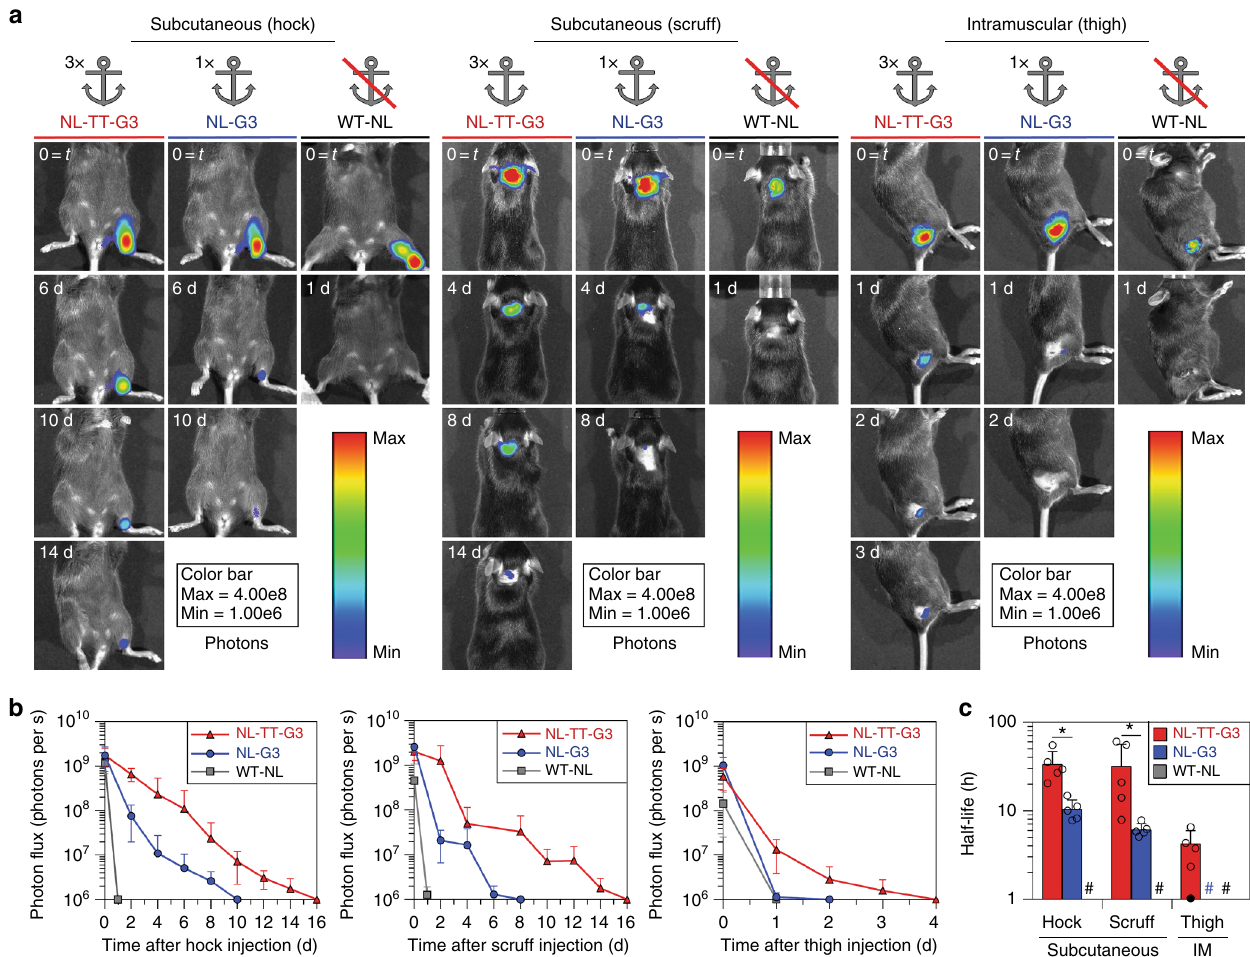
Fig. 5 Injection site half-life of monomeric G3 fusion proteins and trimeric nanoassemblies. a Bioluminescence images and b photon fl ux at various time points for mice that received NL-TT-G3, NL-G3, or WT-NL (equivalent moles of NL) in the hock, scruff, or thigh. c Biocatalytic activity half-life of NL-TT-G3, NL-G3, or WT-NL in different tissues. N = 5, mean ± s.d., * p < 0.05, ANOVA with Tukey ’ s post hoc. In c , open circles represent each half-life calculation, closed circle represents individual animals for which half-life could not be accurately calculated due to rapid enzyme clearance from the injection site, and hash sign represents groups for which half-life could not be accurately calculated due to rapid enzyme clearance from the injection site (signal at t = 24 was at baseline for ≥ 3 animals in a cohort). Data for WT-NL appear as gray bars/squares/traces, NL-G3 as blue bars/circles/traces, and NL-TT-G3 as